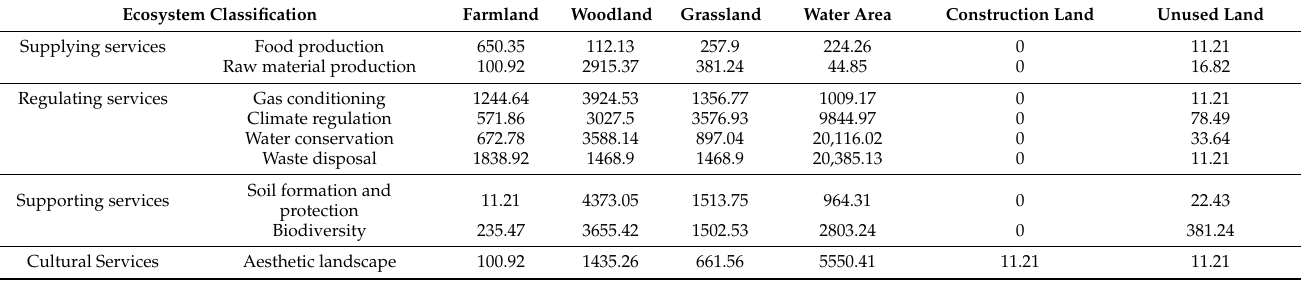
Table 1. Ecological service value equivalents of different LULC in the Manas River Basin (CNY (ha · a) –1 ). Farmland Woodland Grassland Water Area Construction Land Unused